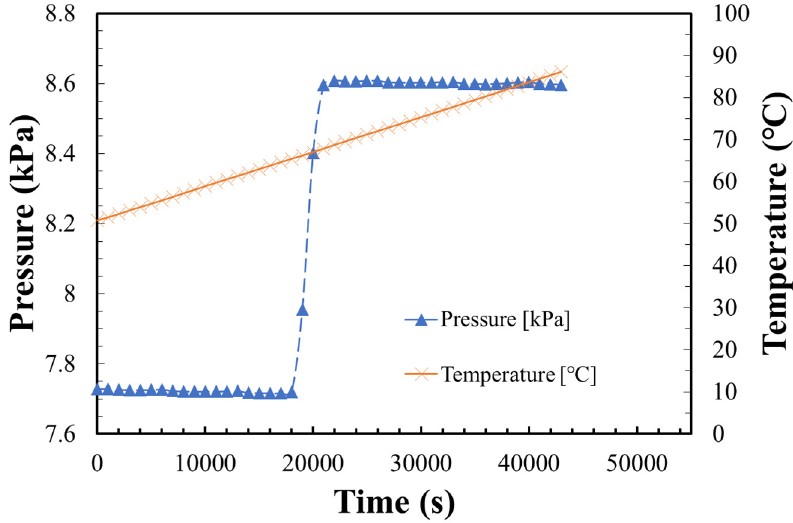
Figure 4. Pressure and temperature change in the measurement of the dehydration reaction.